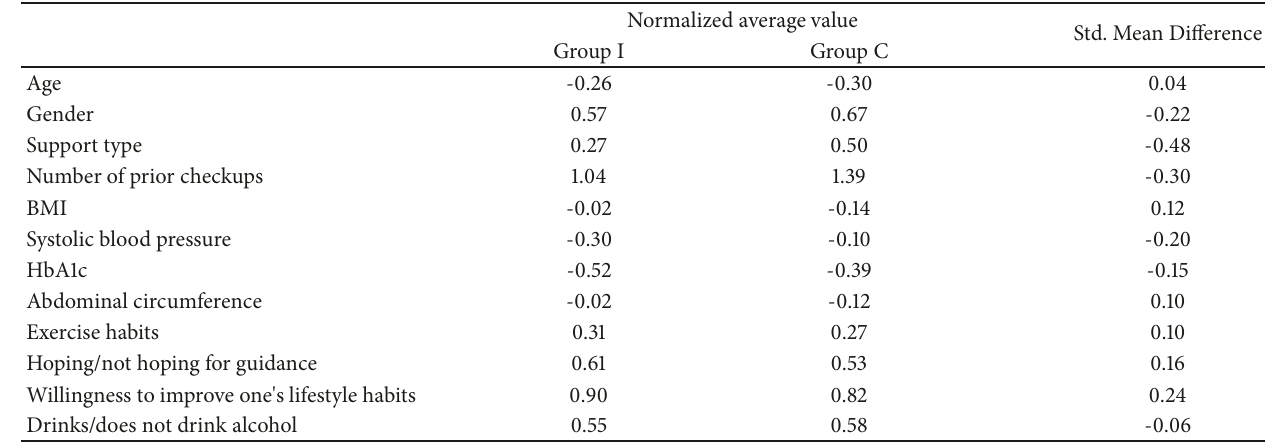
Table 3: Normalized average value of the two